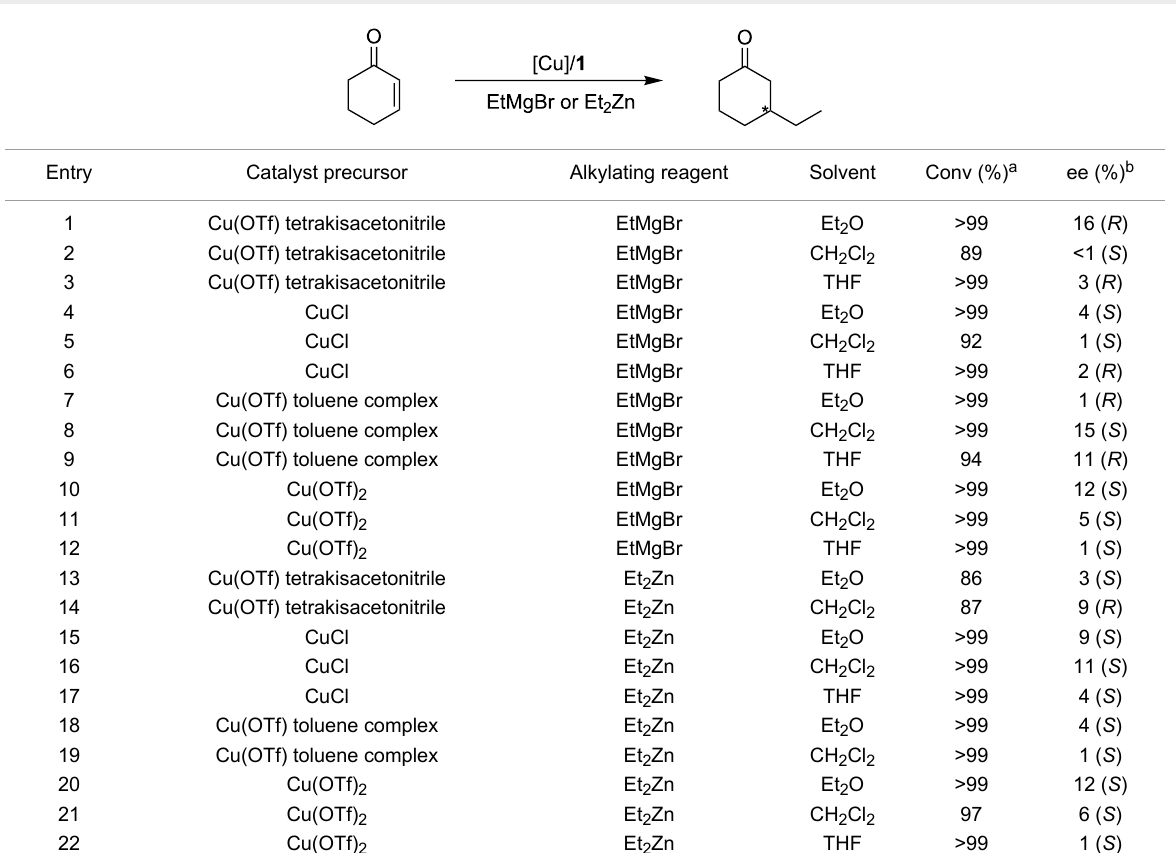
Table 2: Asymmetric ethyl addition to 2-cyclohexen-1-one under different conditions.